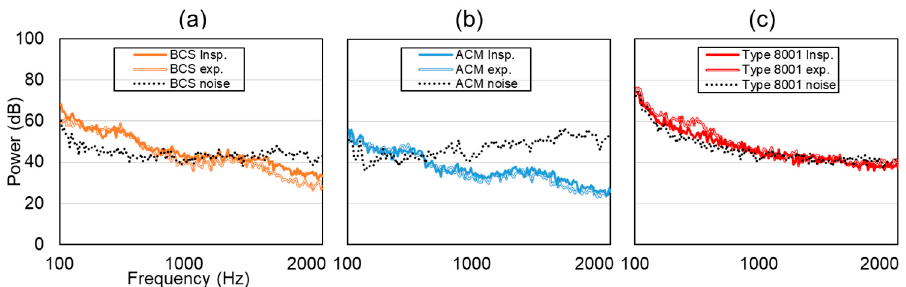
Figure 10. Experimental results of normal breathing tracheal sound in a noisy environment. ( a ) BCS, ( b ) ACM, ( c ) Type 8001, where the solid line represents the inspiration process, the double solid line is expiration, and the dotted line represents noise.